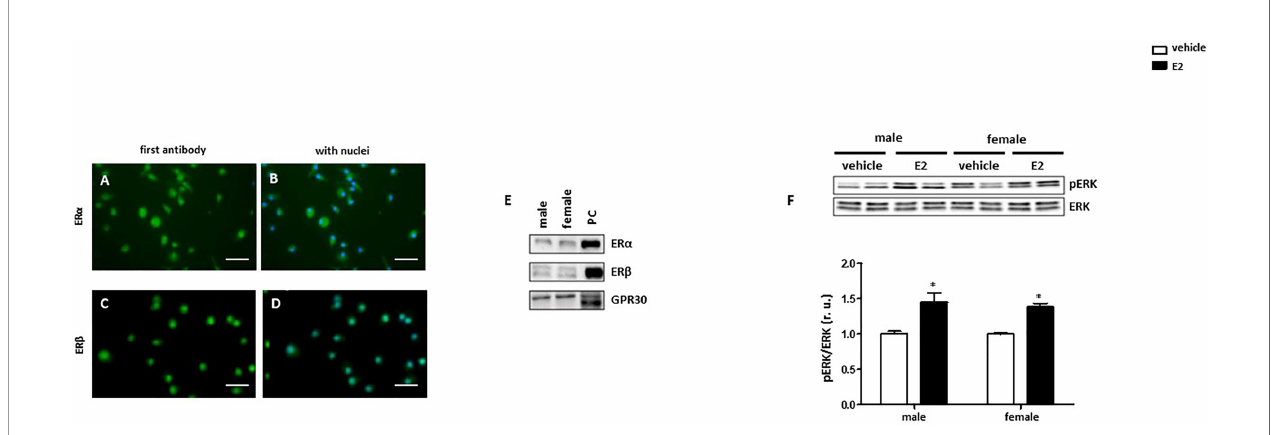
FIGURE 2 | Male and female BMMs express active estrogen receptors. Representative images of BMMs cells stained against (green) (A, B) ER a and (C, D) ER b . Nuclei were stained with DAPI (blue) (B, D) . Magni fi cation: 40x, scale bar: 50 µm. Western blot analysis of (E) ER a , Er b , and GPR30 and (F) pERK/ERK ratio in male and female BMMs with or without E2 treatment for 24 hrs. Data are representative of 3 independent experiments with similar results. Data are normalized to the male untreated group and expressed in relative units (r. u.). *p < 0.05, untreated vs. treated. PC = positive control (MCF7 lysate).